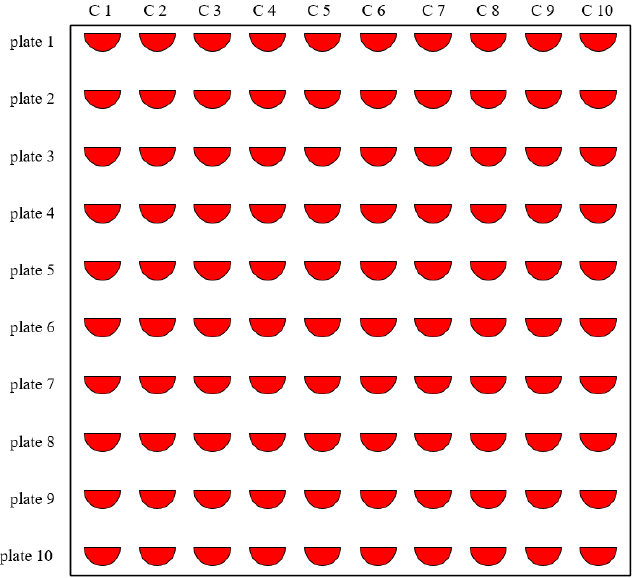
Figure 4. Schematic diagram of the PCHE inner layer number and flow channel number.